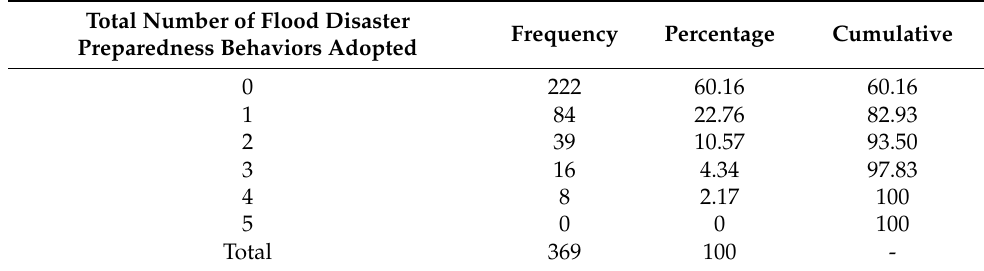
Table 2. Frequency of urban households’ total number of flood disaster preparedness behaviours adopted in the Odaw river flood plains study area ( n =